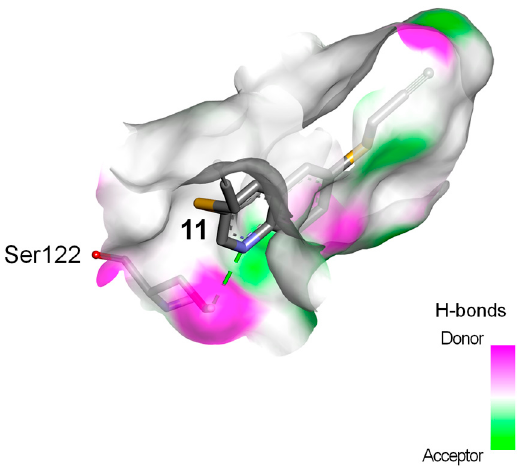
Figure 5. Conventional hydrogen bond (green and dashed line) formed between compound 11 and Ser122 residue in the active site of human CYP1A1. The active site’s cavity is visualized as a solvent and partially transparent surface.